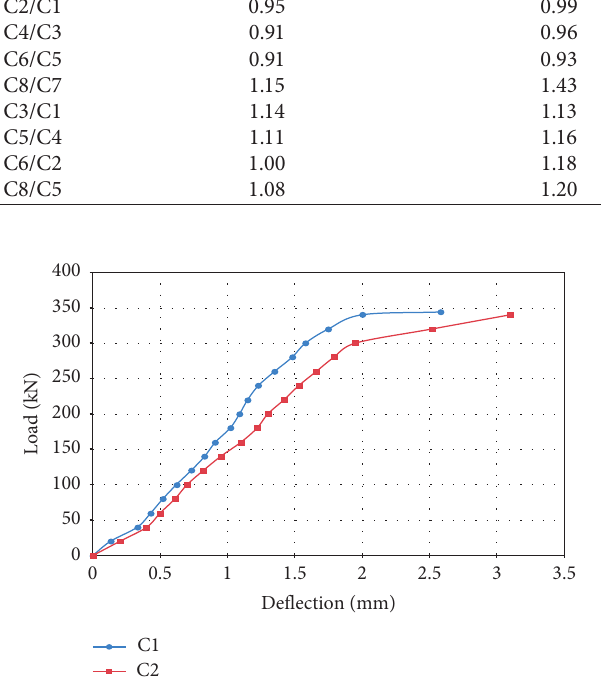
Figure 6: Load-deflection relationship of corbels with 0% and